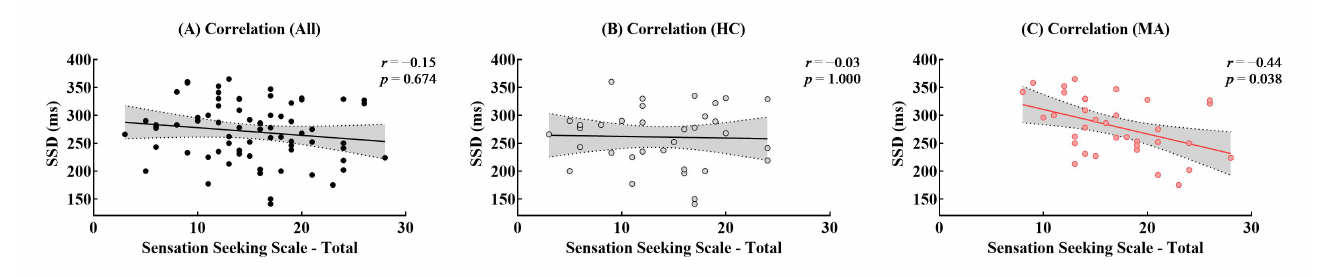
Figure 4. Scatter plots of SSD and total Sensation Seeking Scale scores with regression lines and 95% CIs in all participants ( A ) and the HC ( B ) and MUD groups ( C ). Note: r , Pearson correlation coefficient; p -values corrected by